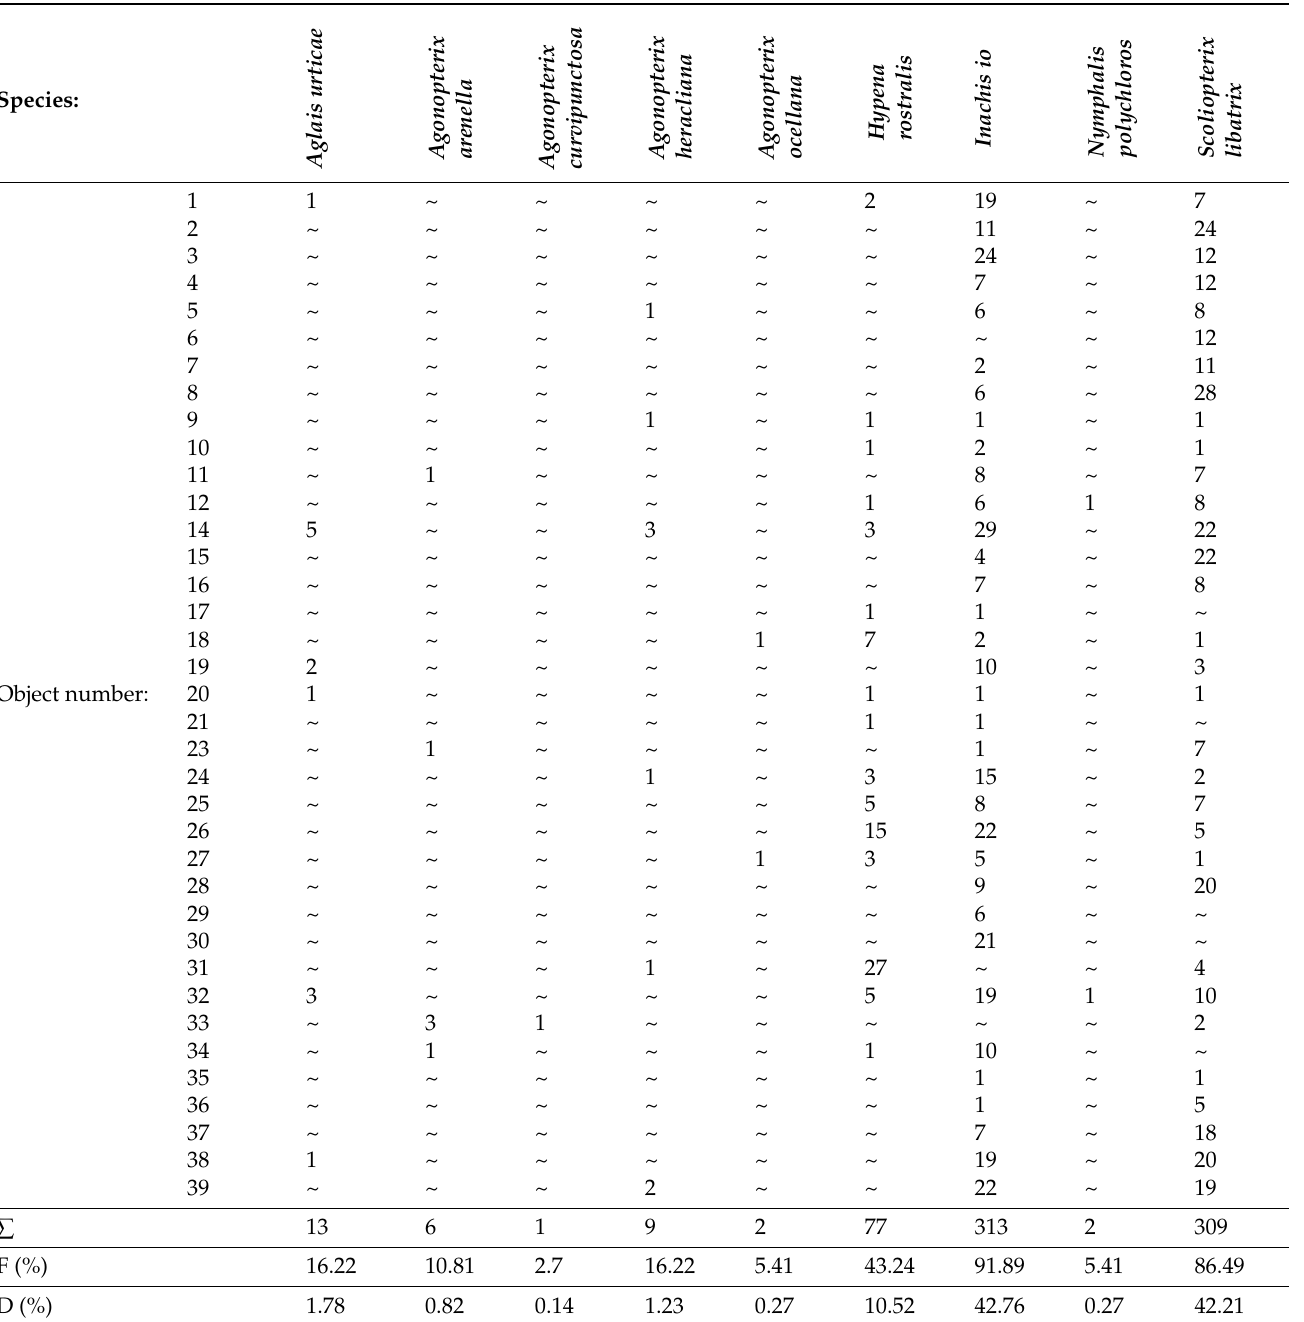
Table A6. Species of butterflies and moths (Lepidoptera) and their abundances in each SA-CEFs in 2014, F—frequency in %, D—dominance in